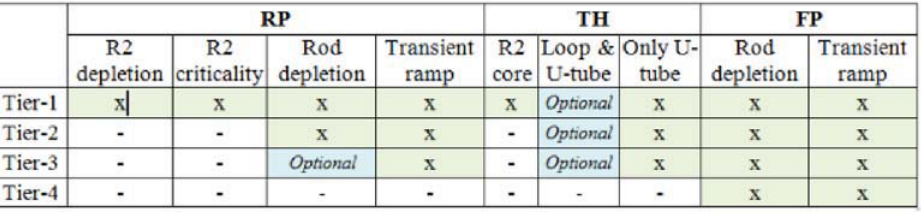
Table 1: Tiers of the MPCMIV benchmark covering Reactor Physics (RP), Thermal-Hydraulics (TH) and Fuel Performance (FP) of the reactor core and experimental